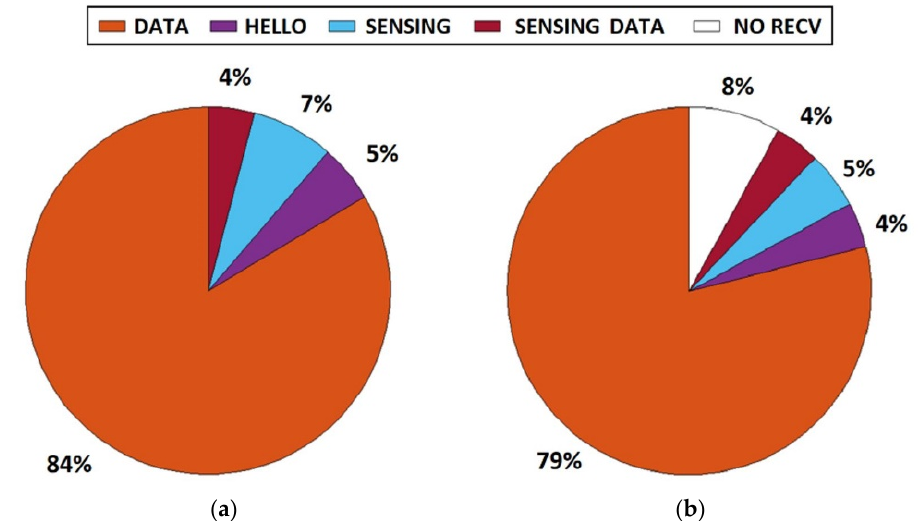
Figure 14. Packet type exchange between nodes 2 and 1: ( a )—sent from node 2, ( b )—received by node